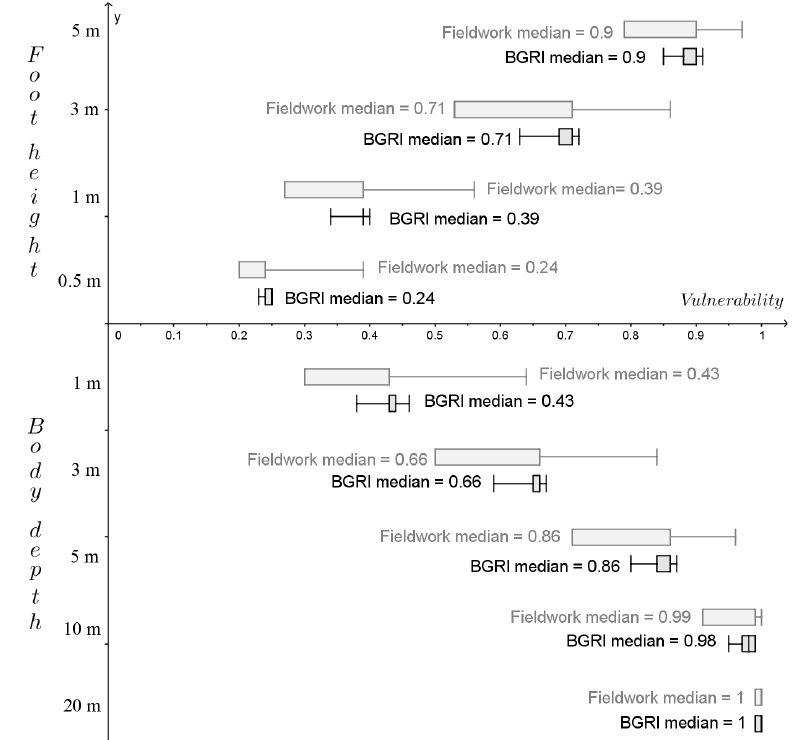
Figure 11. Box plots of the vulnerability of the test site buildings for each scenario, for the buildings inventoried by fieldwork (in grey) and for the buildings of the BGRI subsections (in